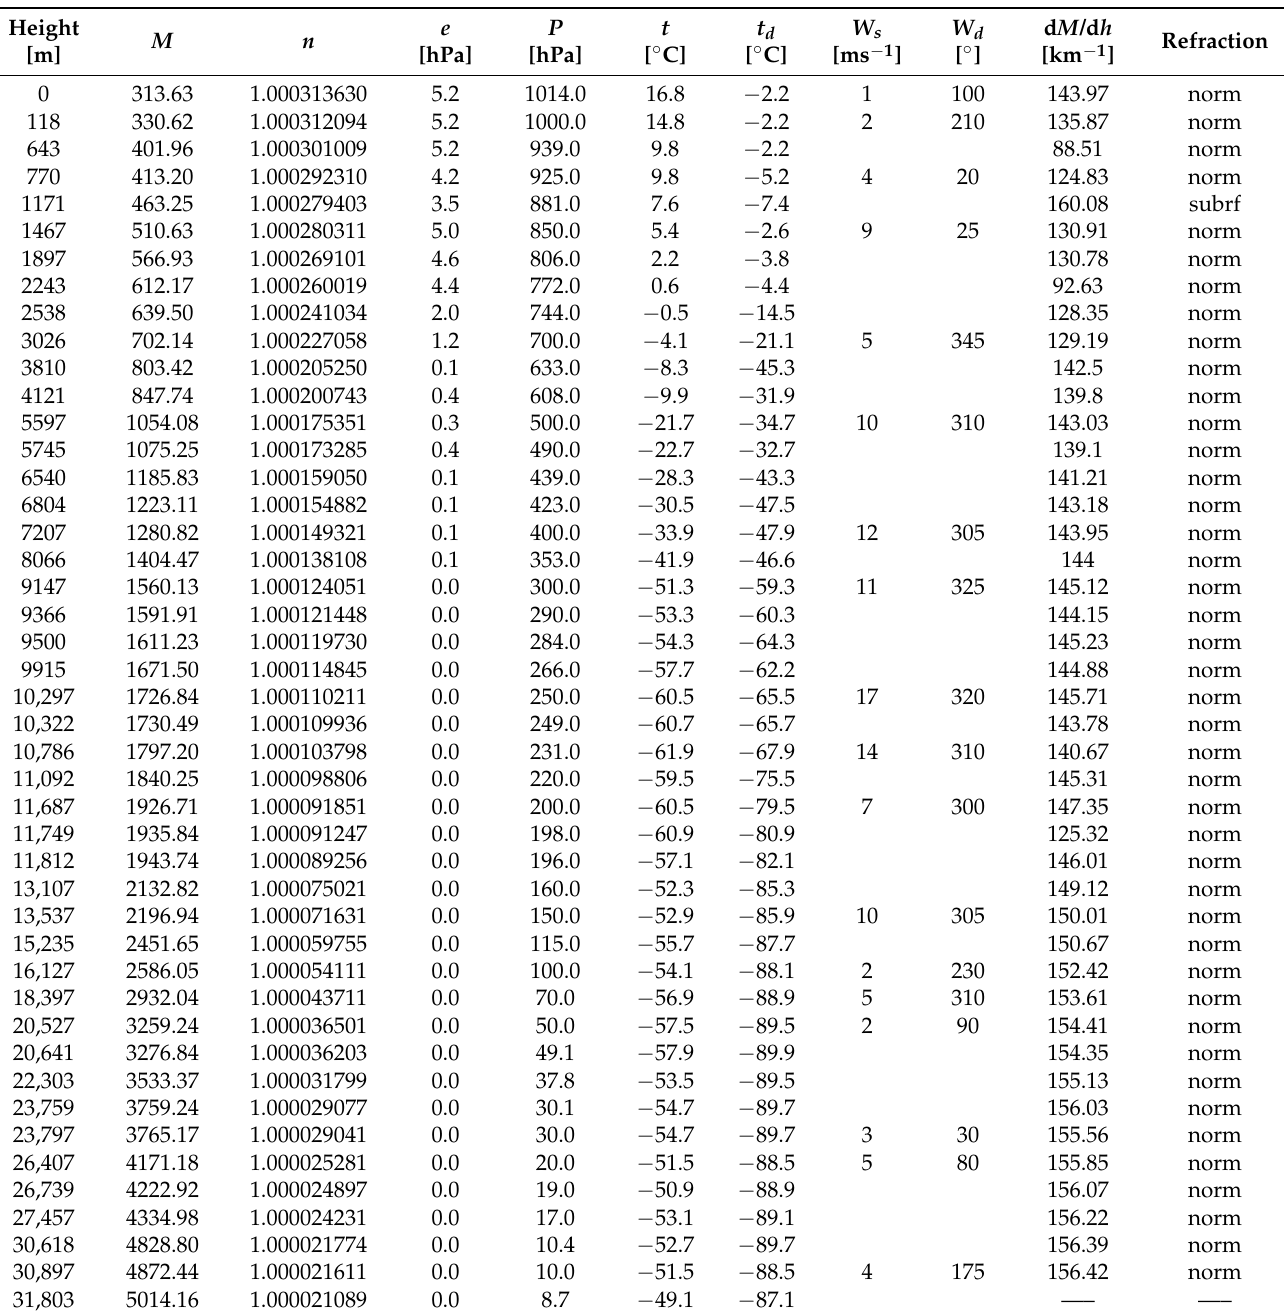
Table A1. Aerological soundings data and refractive profiles on 17 March 2020 at meteorological station Zagreb Maksimir (WMO index